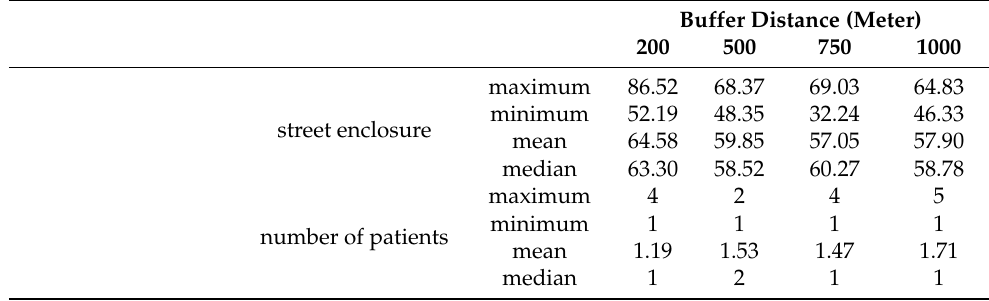
Figure 7. GVI spatial distribution map.